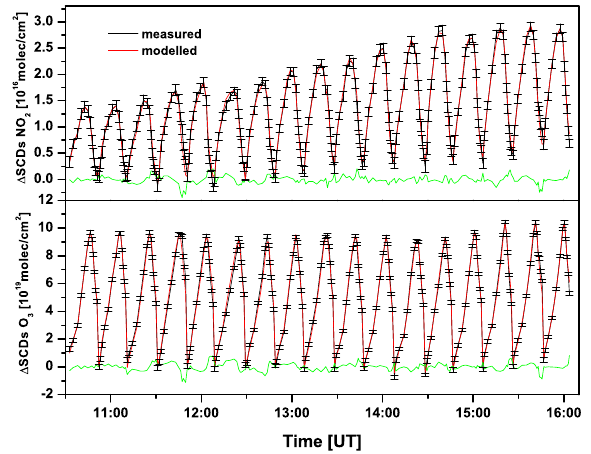
Fig. 2. Measured (black) and forward modeled (red) Δ SCDs for the June 30, 2005 flight. The difference between forward modelled and measured Δ SCDs is shown in green. Upper panel: NO 2 . Lower panel: O 3 described in section 2.3. The oscillating pattern of the Δ SCDs is a consequence of consecutive limb 145 scans. Since the balloon is floating slightly above the maximum of the NO 2 layer in the stratosphere, the first elevation EA= 0.5 ◦ leads to lower NO 2 - Δ SCDs than measurements looking through the profile maximum somewhat lower in the atmosphere. Accordingly as the viewing direction moves closer to the maximum of the NO 2 layer, the Δ SCDs increase. They reach a maximum for an ele- vation EA= -2.5 ◦ and then decrease again while the elevation angles continue to decrease. Here the 150 reference spectrum for the spectral analysis of NO 2 is taken at EA= 0.5 ◦ . A more quantitative un- derstanding of the observation is obtained including radiative transfer modelling which is described in the following subsection.